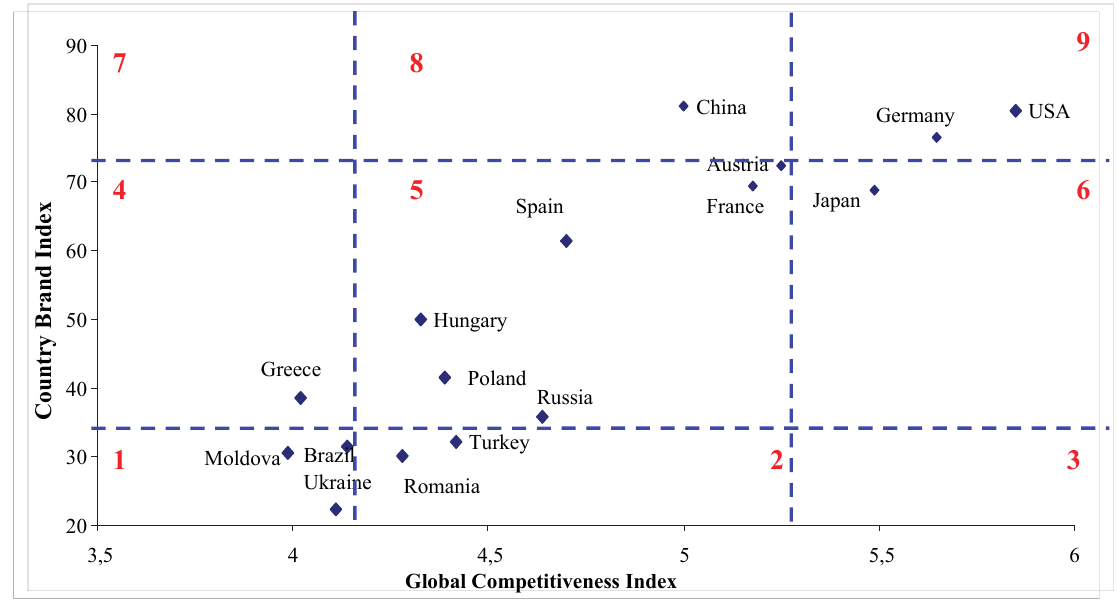
Fig. 2. Positioning of the countries by Country Brand according to the Shell/DPM (built by the author based on Schwab (2017) and own